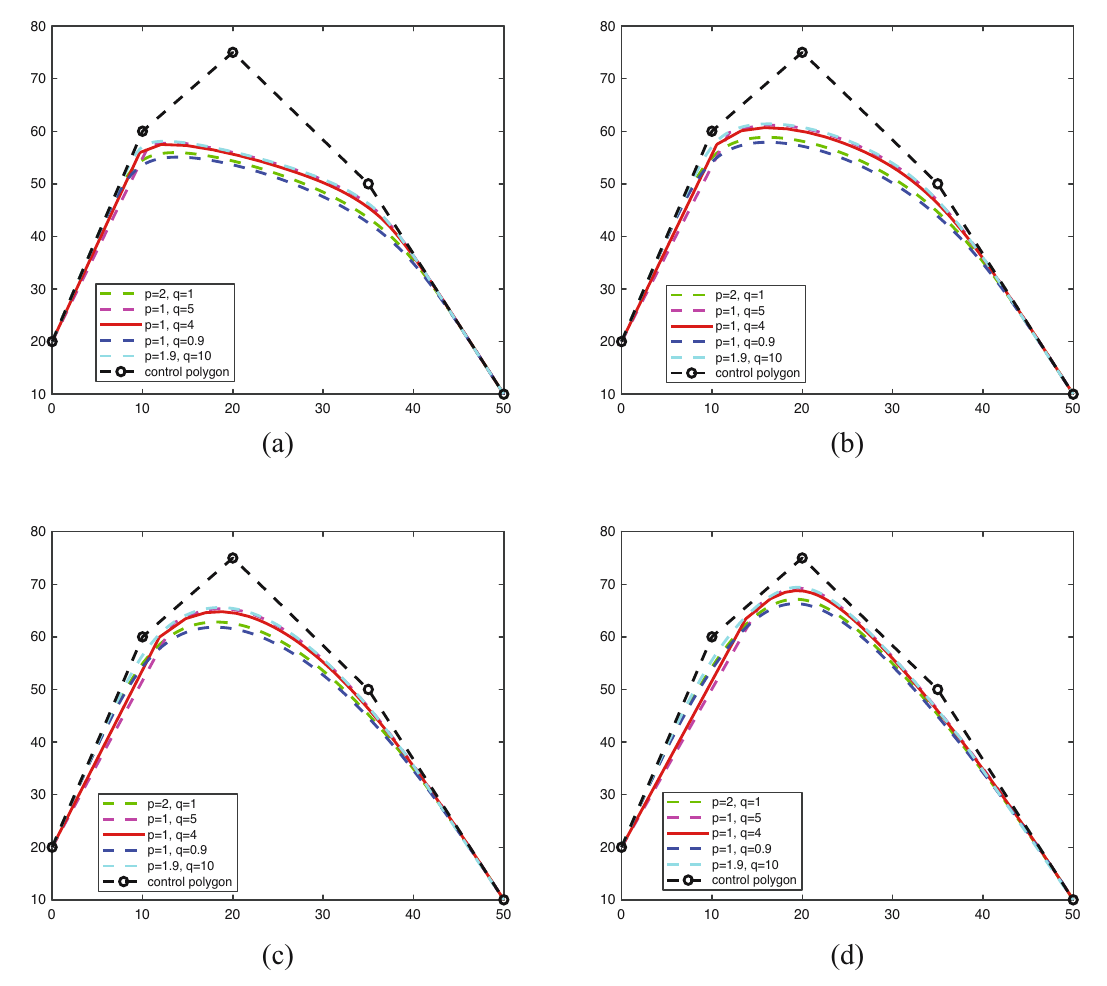
Figure 2: The e ff ect on weighted Lupa ş p q , ( ) - Bézier curves by changing weight w 2 .